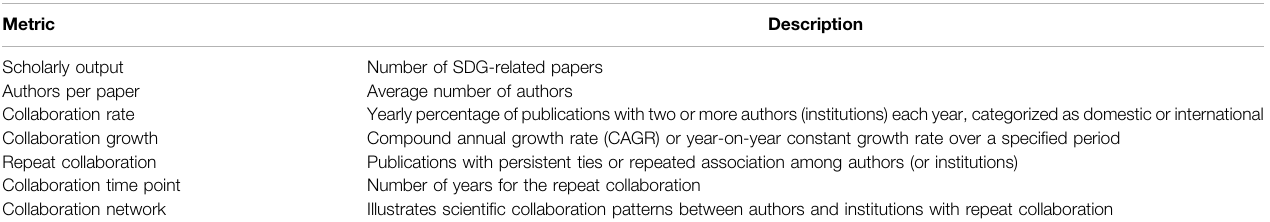
TABLE 1 | Metrics used in pro fi ling research outputs and collaboration in SDG-related research. Metric